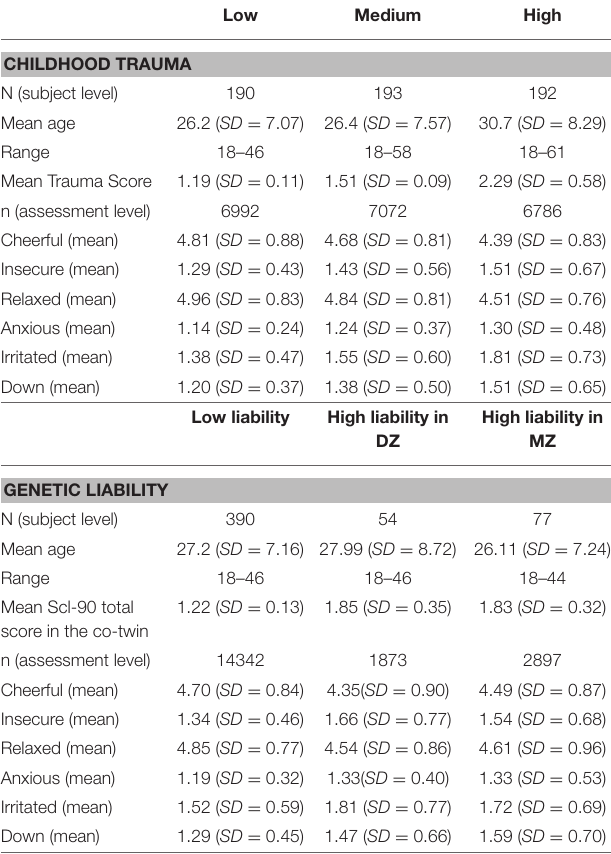
TABLE 1 | Descriptives stratified by childhood trauma and genetic